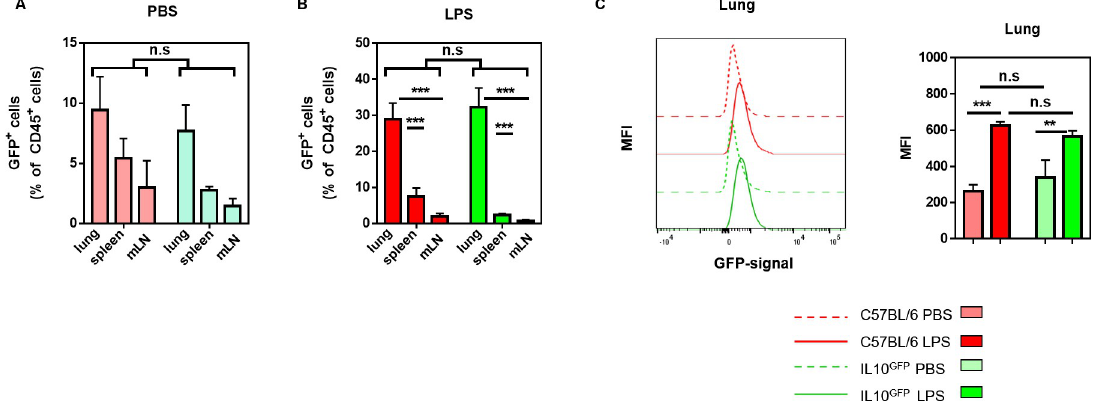
Fig 1. The myeloid-derived GFP signal is comparable between IL10 GFP and C57BL/6 mice and increases during lung inflammation. C57BL/6 and IL-10 GFP mice were challenged three times (d0, d1, d2) with either PBS or 10 μ g LPS per mouse via aspiration. 16–18 hours after the last administration, the single cell suspension from lungs, spleens, and mLNs were stained for CD4 + T cells (CD45 + CD45R/ B220 - CD3 ε + CD4 + CD8 α - ), CD8 + T cells (CD45 + CD45R/B220 - CD3 ε + CD4 - CD8 α + ), macrophages (CD45 + CD45R/B220 - CD3 ε - Siglec-F - F4/80 + ), Siglec-F + cells (eosinophils, alveolar macrophages; CD45 + CD45R/B220 - CD3 ε - Siglec-F + F4/80 -/+ ), neutrophils (CD45 + CD45R/B220 - CD3 ε - Siglec-F - F4/80 - Ly6G + CD11b + ), monocytes (CD45 + CD45R/B220 - CD3 ε - Siglec-F - F4/80 - Ly6G - Ly6C + CD11b + ), and ILCs (CD45 + CD45R/B220 - CD3 ε - Siglec-F - F4/80 - Ly6G - CD90.2 + CD127 lo/- ). The expression of IL-10 was measured either by GFP + or by intracellular IL-10 as indicated. (A, B) The frequency of GFP + cells (live CD45 + ) in the lungs of (A) PBS or (B) LPS challenged C57BL/6 (red) and IL-10 GFP (green) mice are shown. The graph shows combined data from three independent experiments (PBS: n = 9 mice/group, LPS: n = 13–15 mice/group in total). (C) Representative histogram showing the shift in the GFP-signal (505 nm —550 nm) of live CD45 + lung cells upon LPS administration in C57BL/6 and IL-10 GFP mice